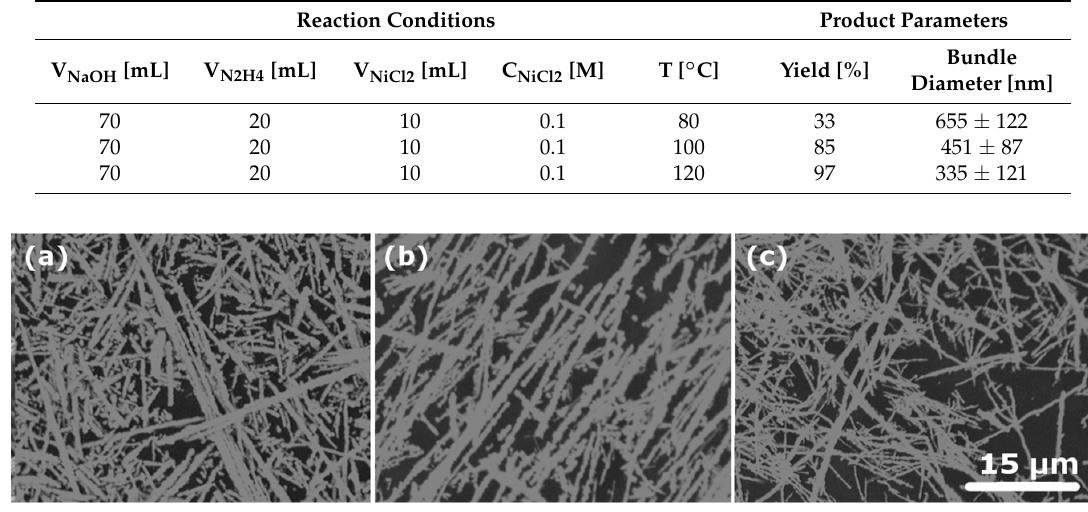
Figure 1. Micrographs of the NiNWs formed at different temperatures: ( a ) 80 °C, ( b ) 100 °C and ( c ) 120 °C.